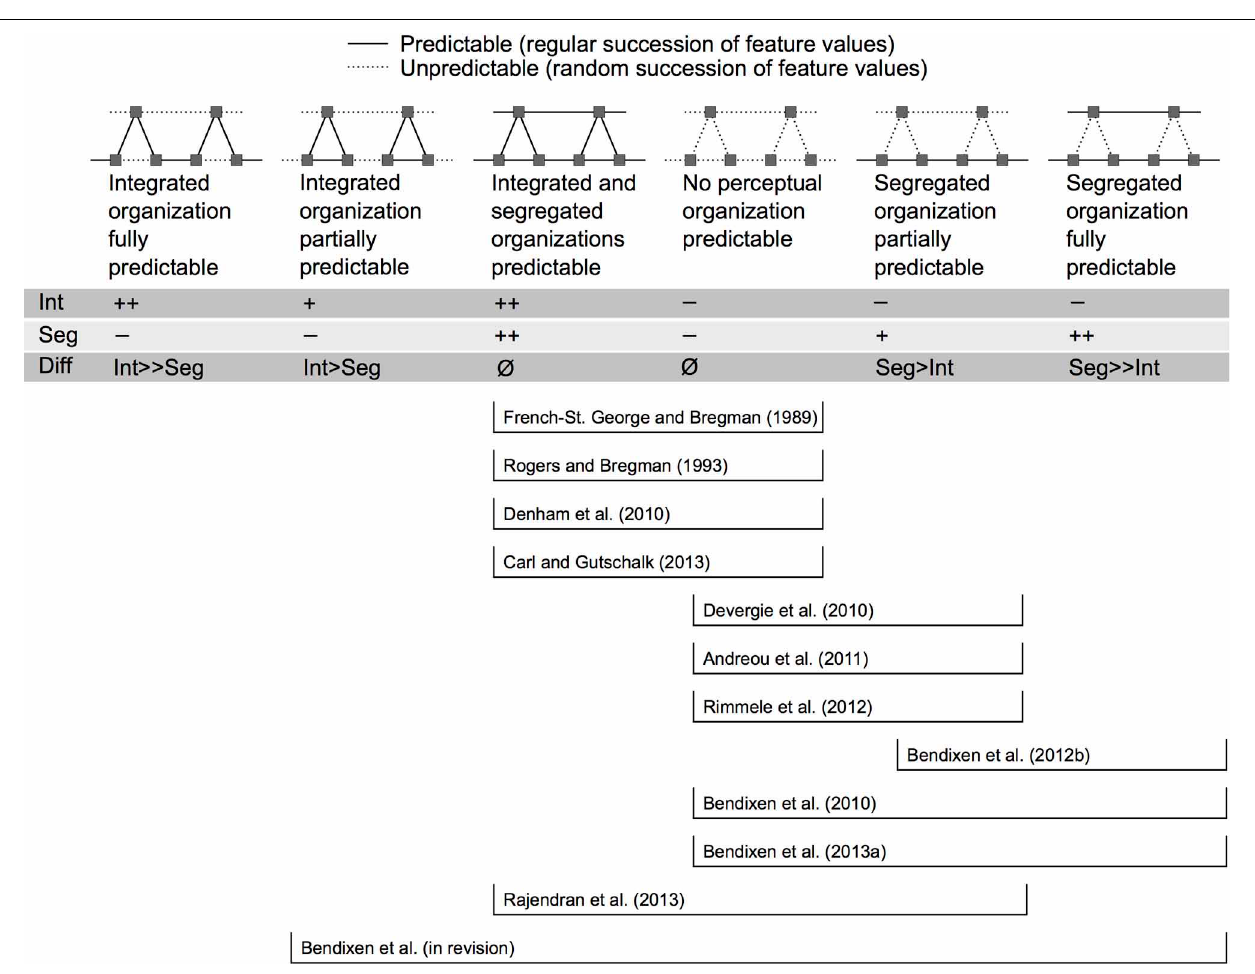
FIGURE 3 | Designs for studying predictability effects in auditory scene analysis. Six different levels of predictability are distinguished; and it is indicated for each of the previous studies which levels they have contrasted. Each level is schematically illustrated with a cutout of the corresponding stimulus sequence. Time is represented on the X axis and frequency on the Y axis of all panels. The schematic depiction uses the “ABA_” paradigm (Van Noorden, 1975), but studies have also used the “ABAB” paradigm or more irregular arrangements of “A” and “B” tones. Straight lines indicate the presence of predictive relations between successive tones (i.e., the feature values of one tone are predictive of the feature values of the next tone in one or both perceptual organizations). Dotted lines indicate random successions of feature values. The feature whose predictability was manipulated differs between studies (e.g., onset time, frequency, intensity, location). The effects on predictability of the